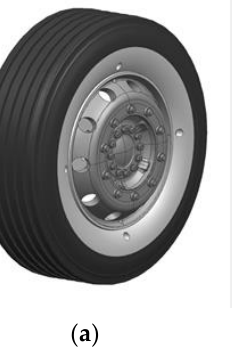
Figure 4. Investigated rim shapes: ( a ) “Standard” front wheel rim; ( b ) Flat “eco rim” with ventilation openings based on [10]; ( c ) Flat “closed rim”.